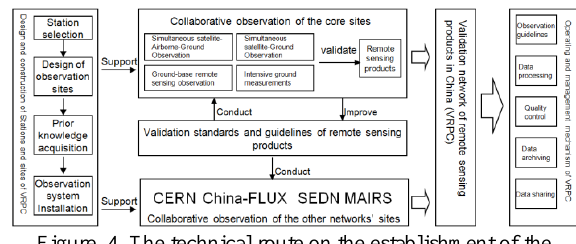
Figure. 4 The technical route on the establishment of the national validation network